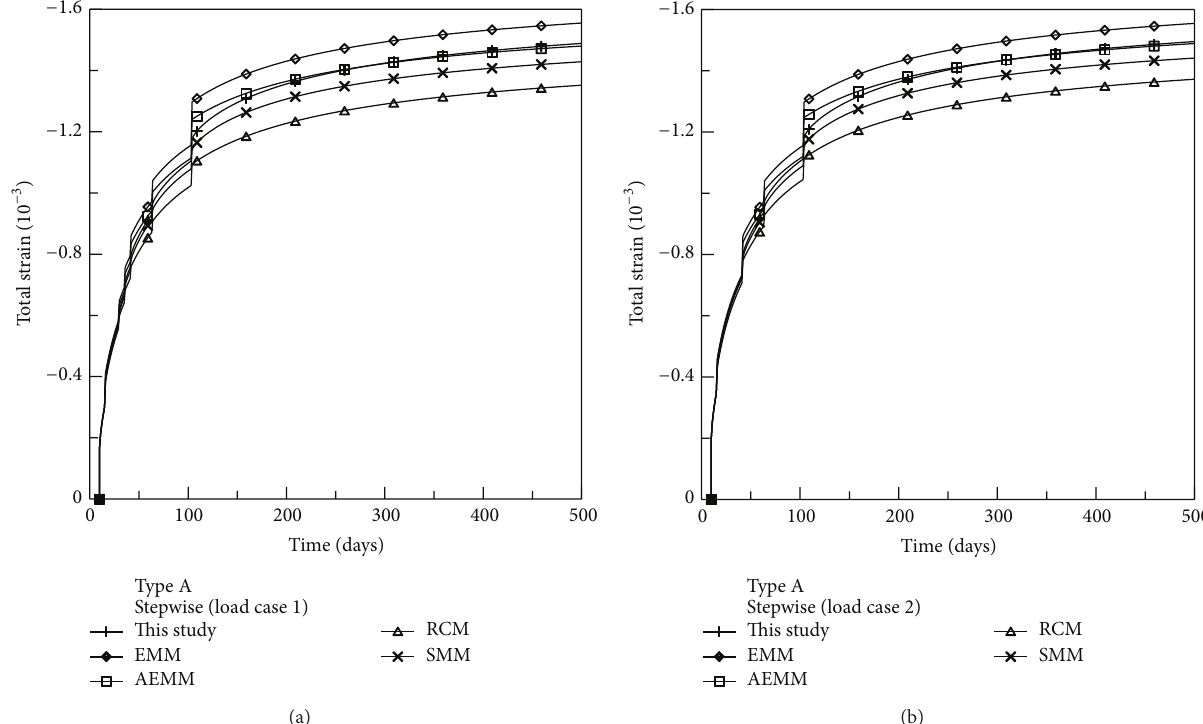
Figure 12: Extended predictions and comparison of the total strain by the five creep models (type A test): (a) load case 1 and (b) load case